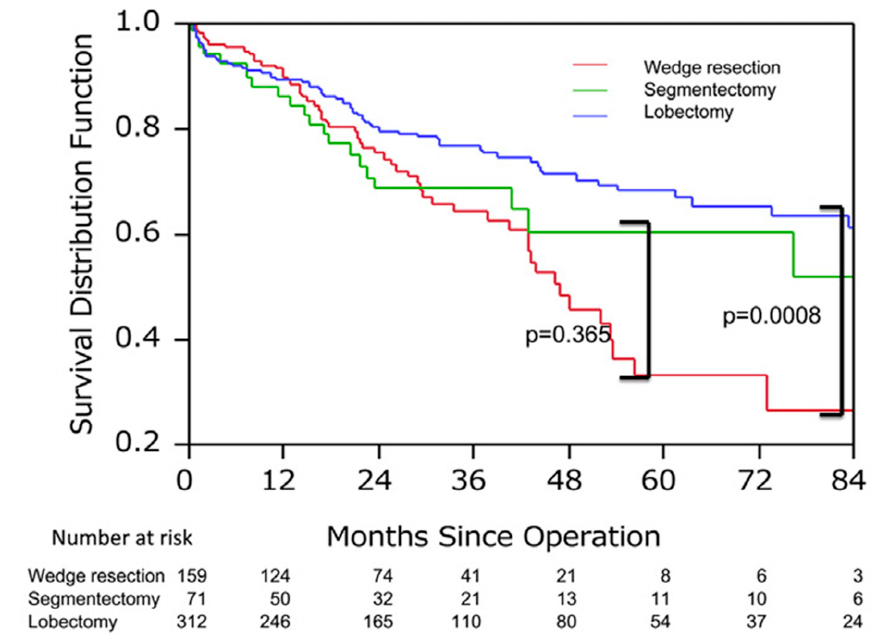
Figure 2. The survival associated with the surgical procedure in patients with stage IA interstitial pneumonia (IP)-associated lung cancer. 5-year survival of the wedge resection group (29.2%) was significantly worse than that of segmentectomy (60.0%) or lobectomy group (68.6%). This figure is adapted from Sato T. J Thorac Cardiovasc Surg (2015) 149, 64–70